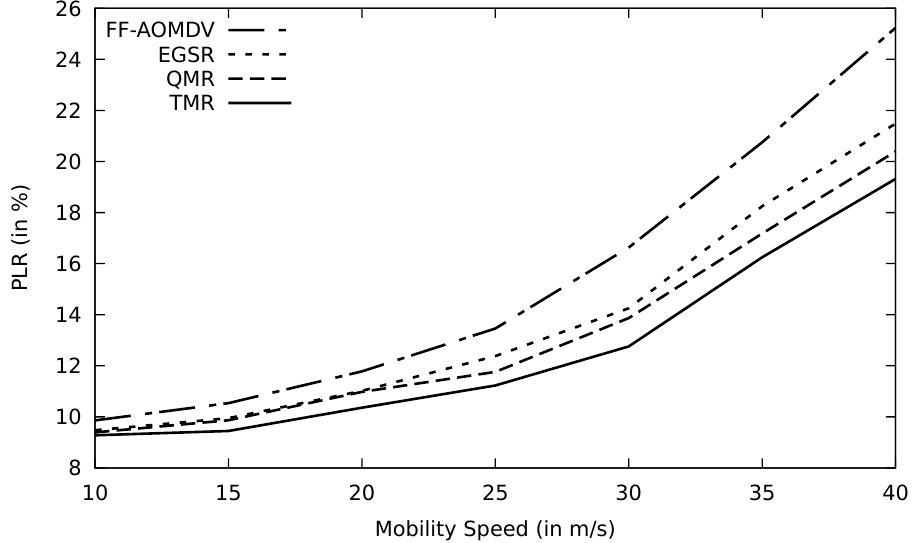
Figure 19. Comparison of FF-AOMDV, EGSR, QMR, and proposed protocol TMR for PLR with mobility